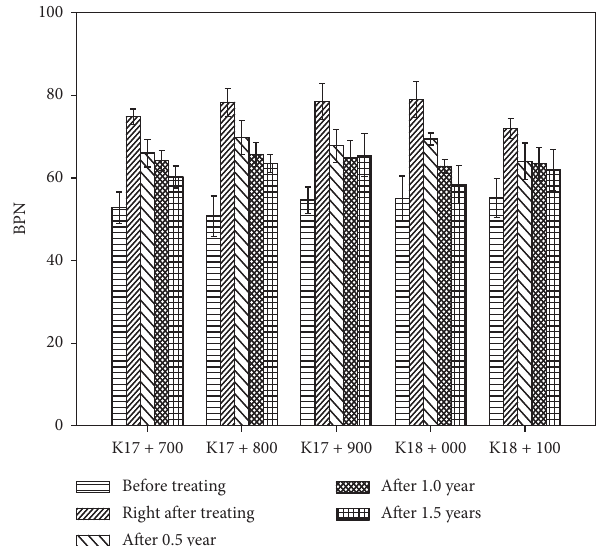
Figure 10: BPD values of pavement surface before and after sand fog